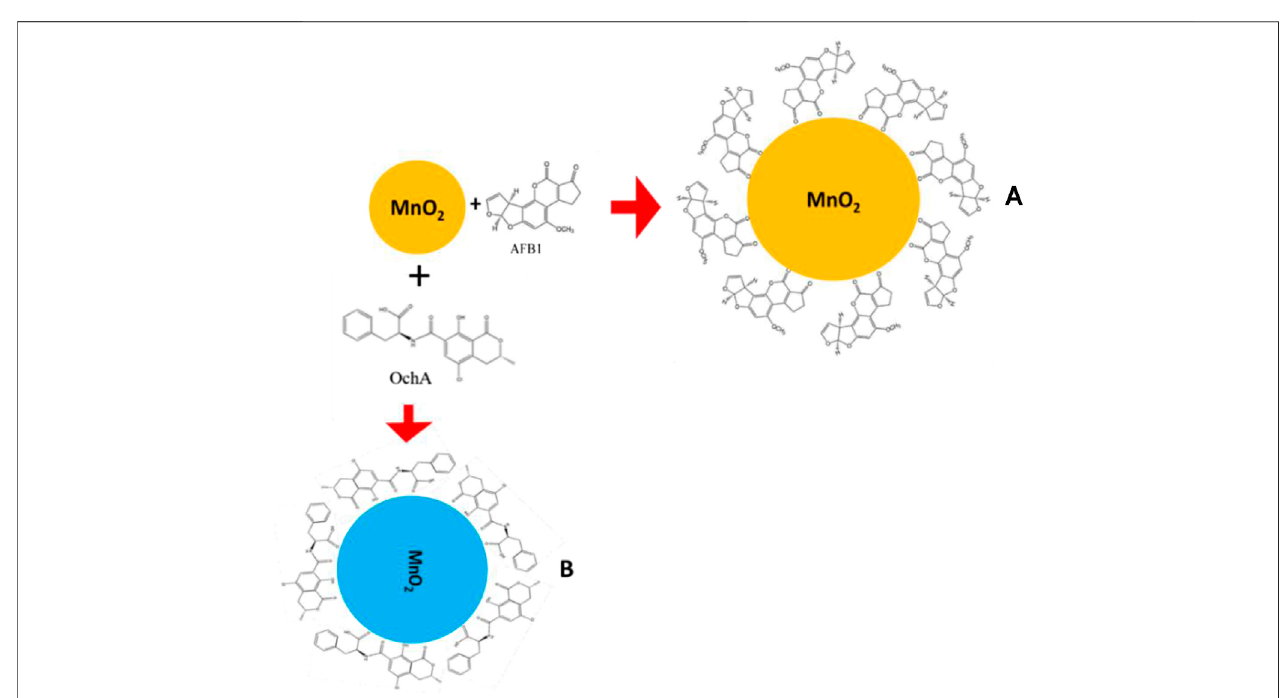
FIGURE 9 | Schematic of interaction between MnO 2 nps and AFB1 (A) and OchA (B) explaining a sequential decrease in the absorbance of OchA.